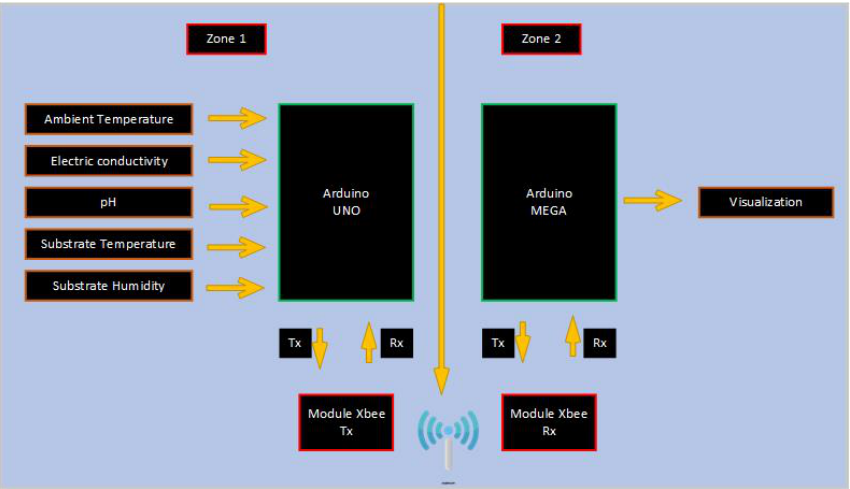
Figure 7. System zonification.